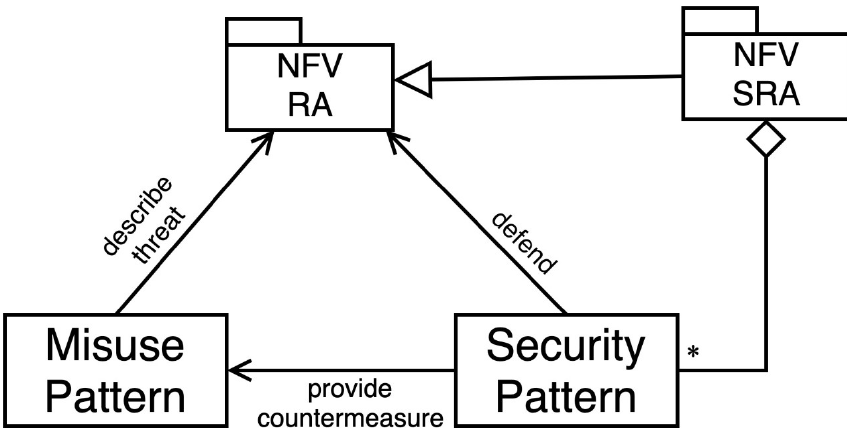
Figure 6. A pattern diagram for the NFV SRA [18].